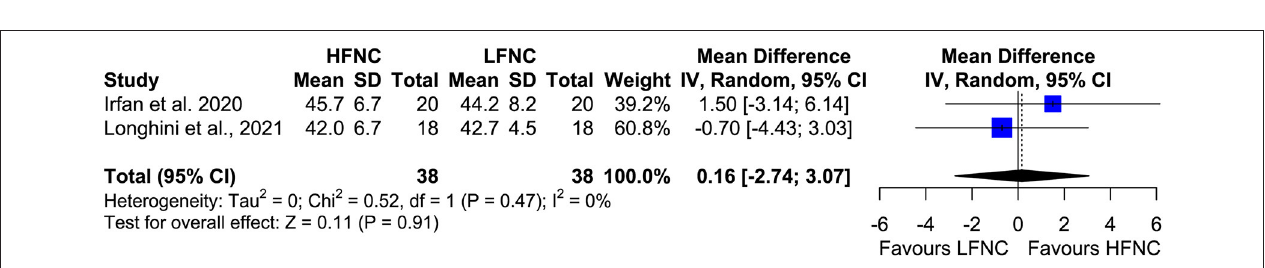
FIGURE 8 | Meta-analysis of end procedural PCO2 in patients receiving HFNC compared to LFNC in patients undergoing bronchoscopic procedures.